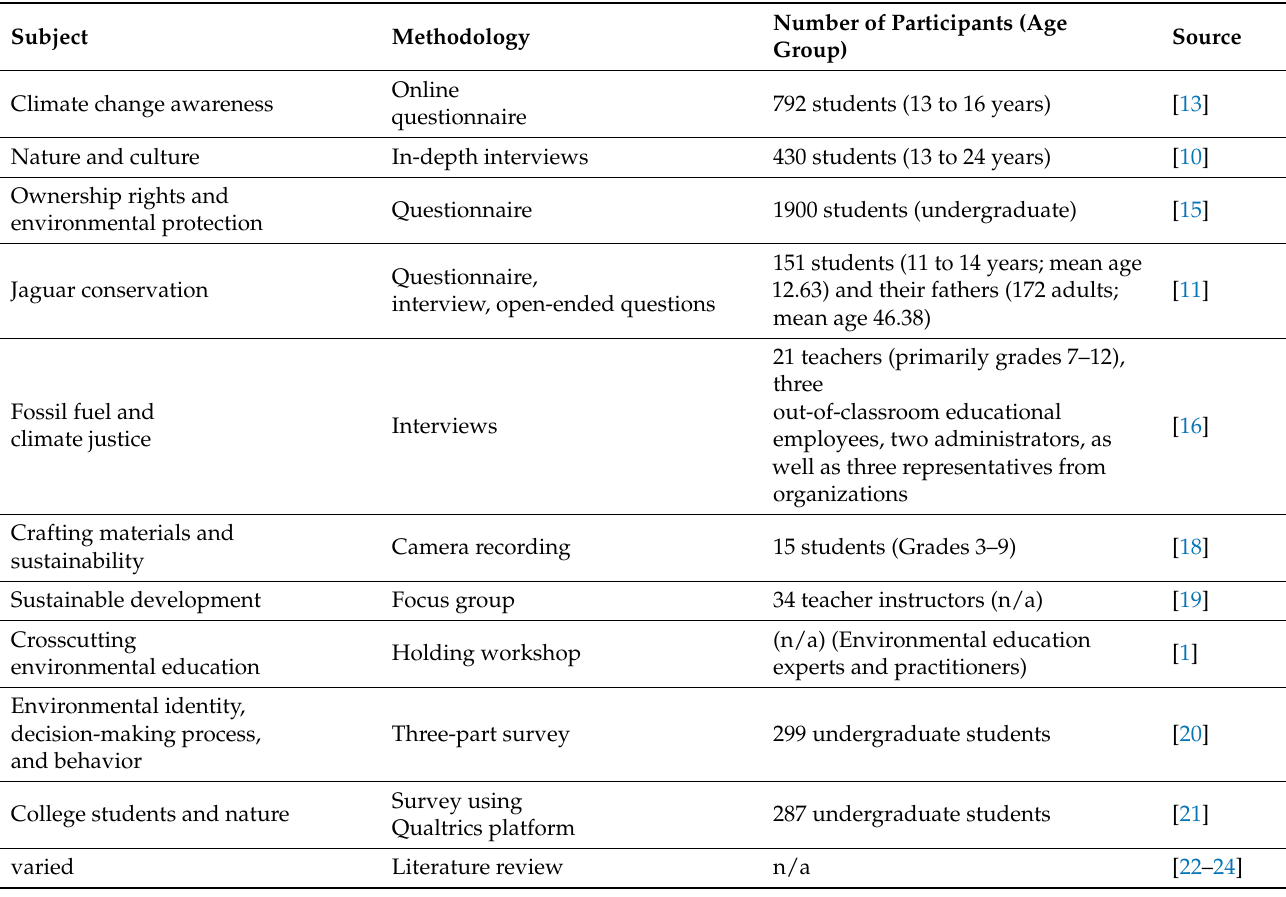
Table 1. Selected research subjects and their associated methodologies in analyzing environmental